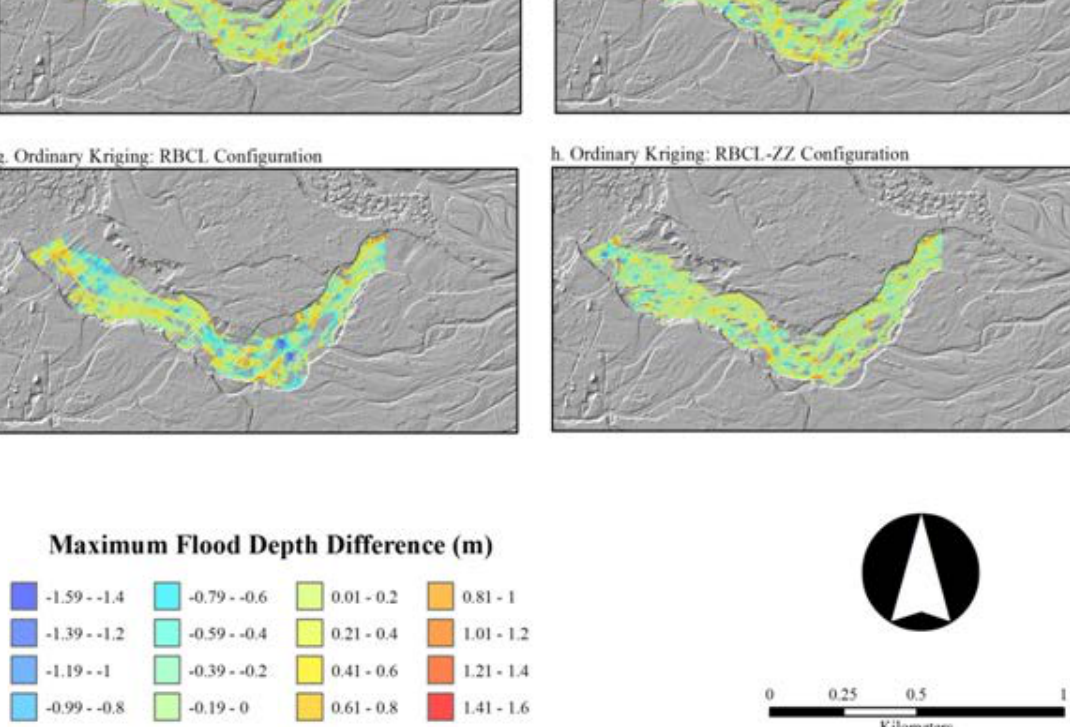
Figure 8. Difference in maximum flood depths simulated by the 2D hydraulic model using the original DTM and 8 bed-integrated DTMs. A negative difference means the maximum flood depth simulated by the model using a DTM with interpolated river bed is greater than the maximum flood depth that is simulated using the original